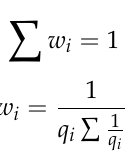
( Fi ) Magnified region of interest form ( C ) ( Fii ) representing the enzyme assignment. ROI is marked in ( Cii ) by a black square. ( Fii ) 20 × 1 pixel line (ROI marked in ( Fi )), in ( Cii ) pixel line y = 235, 253 ≤ x ≤ reference system in each pixel of the selected ROI. Maximum values are displayed bold. The lowest line of the table shows the enzyme assignment based on the maximum w i value. The pixel line in ( Fii ) is 7.8 µ m